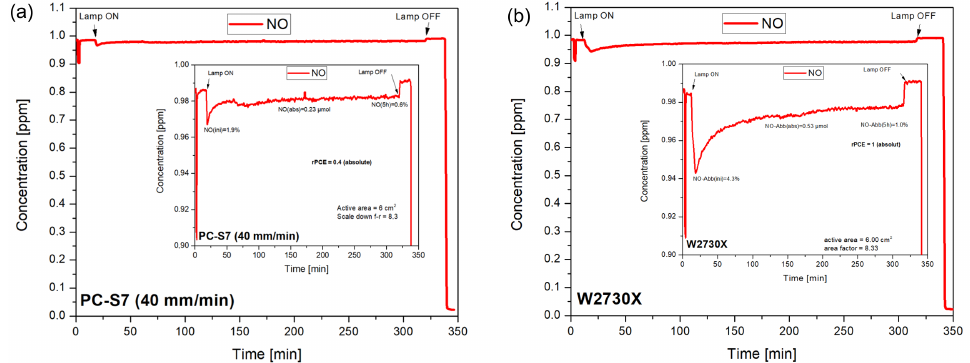
Figure 7. Time-dependent NO concentration of the anodized layers impregnated with PC-S7 (40 mm/min) ( a ) and W2730X (15 wt.%, 10 mm/min) ( b